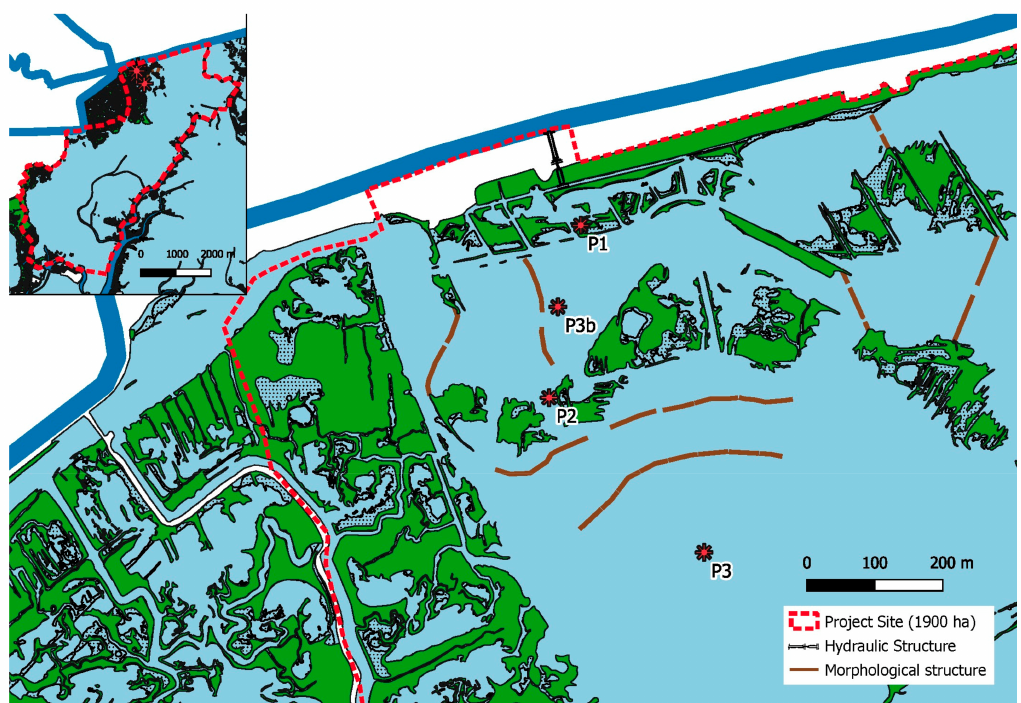
Figure 2. Moored probes: location along a transect within the area in front of Hydraulic and Morphological structures. P1: close to the hydraulic infrastructure; P2: located in an intermediate position; and P3: in a third site outside the morphological structure, considered to be a reference location. P3b position, to investigate suitable condition for reedbed, is also